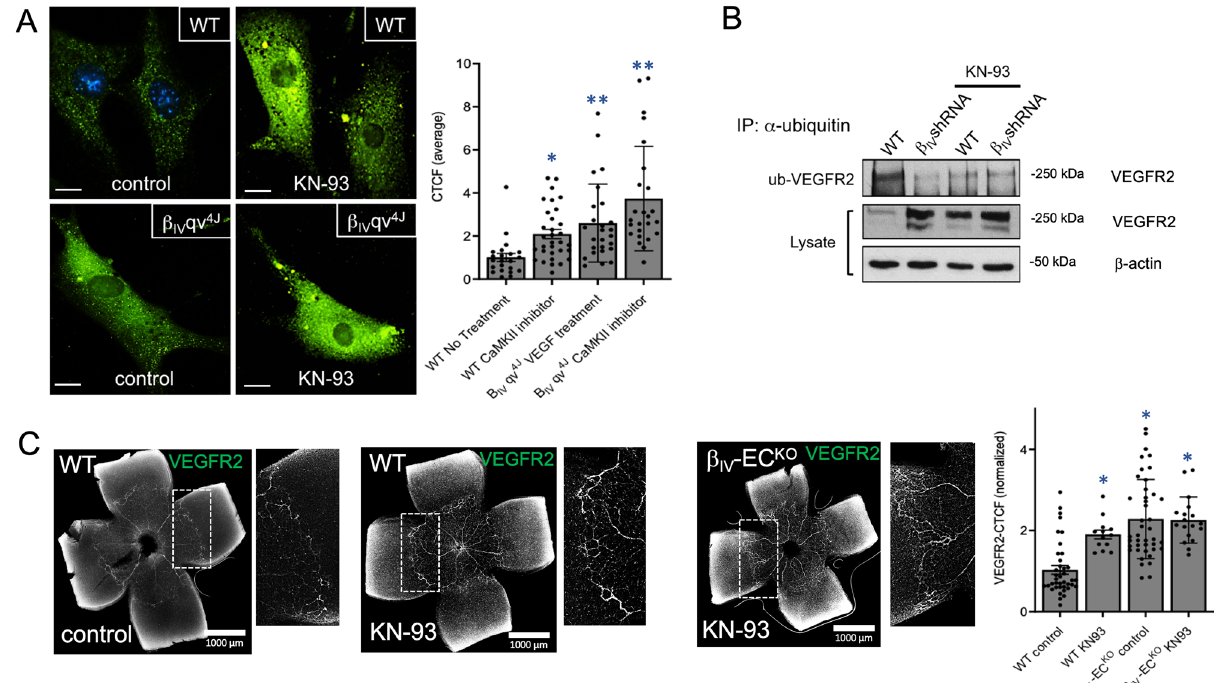
Fig. 5 β IV -spectrin mediates CaMKII-induced VEGFR2 internalization and turnover. A Immuno fl uorescence images indicate cell surface levels of endogenous VEGFR2 in nonpermeabilized control and β IV qv 4J ECs upon treatment with KN-93 (2 μ M for 4 h). Scale bar: 20 μ m. Data is presented as a mean normalized value ± SEM, where n = 22, 32, 26, 25 cells based on 3 independent experiments for WT No treatment, WT CaMKII inhibitor, β IV qv 4J VEGF treatment, and β IV qv 4J CaMKII inhibitor, respectively. A Type 2 t -test results show: * p = 0.0001, ** p = 0.0001 or lower compared to WT. Source data are provided as a Source data fi le. B Western analysis shows immunoprecipitation of total ubiquitin followed by immunoblotting for VEGFR2 in WT versus β IV -shRNA MEECs upon treatment with KN-93 (2 μ M 4 h). Data representative of three independent experiments. C VEGFR2 immuno fl uorescence staining of P5 WT and β IV -EC KO retina upon simultaneous tamoxifen induction and KN-93 treatment via IP injection at P1 and P3. Graph quanti fi cation based on average normalized CTCF values ± SEM, where n = 39, 13, 42, 18 regions of interest in 3 separate mouse retinas for WT control, WT KN-93, β IV -EC KO control, β IV -EC KO KN-93, respectively. A Type 2 t -test results show: * p = 5.34E − 7 or lower compared to P5 WT. Source data are provided as a Source data fi